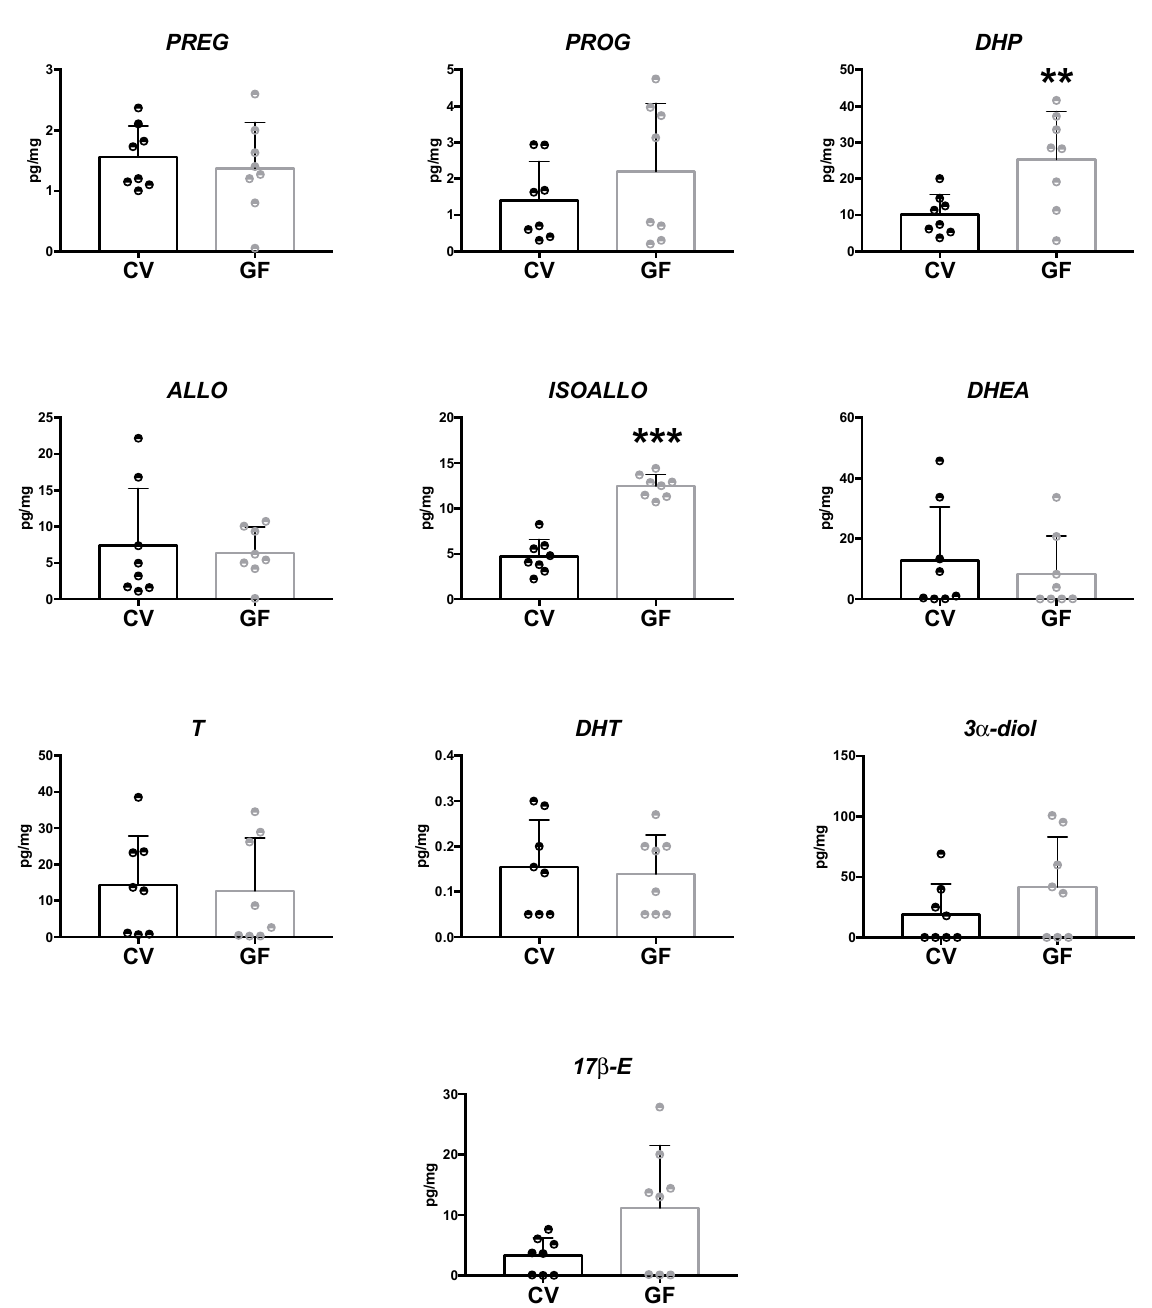
Figure 4. Levels of neuroactive steroids in the cerebral cortex of germ-free (GF) and conventional (CV) male mice. Data are expressed as pg/mg ± SD, n = 8 for each group. Unpaired student’s t -test analysis: ** p < 0.01 *** p < 0.001 vs. CV mice.